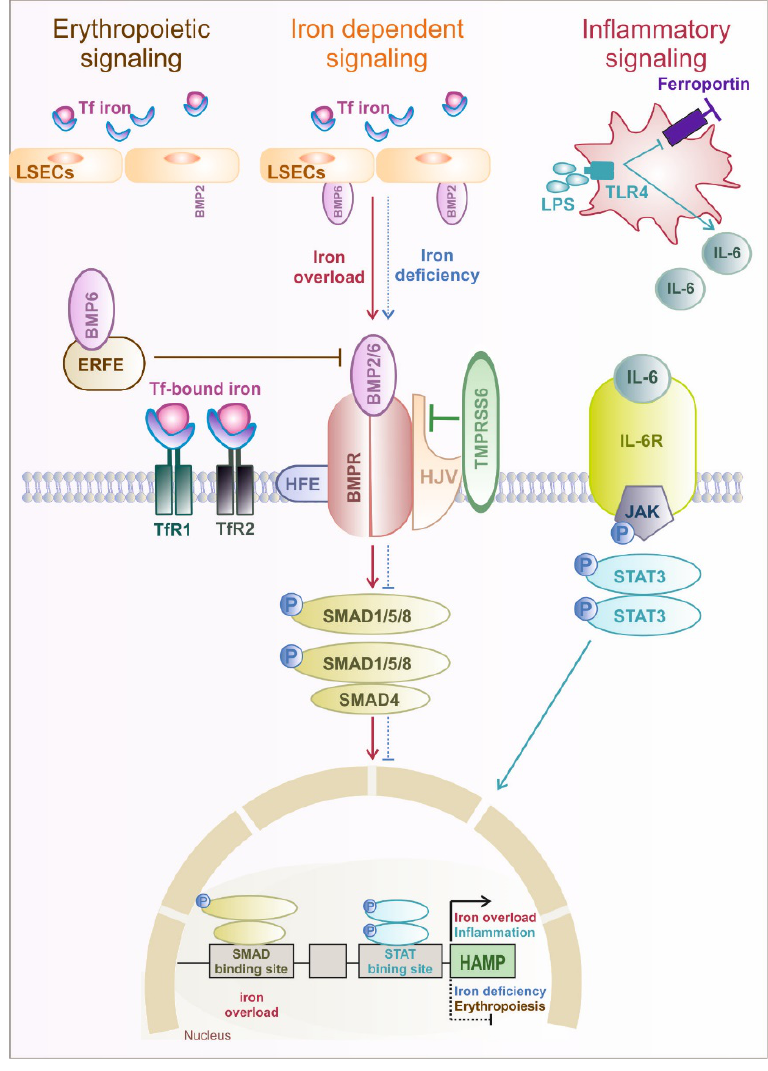
Figure 2. Mechanism regulating hepcidin expression.